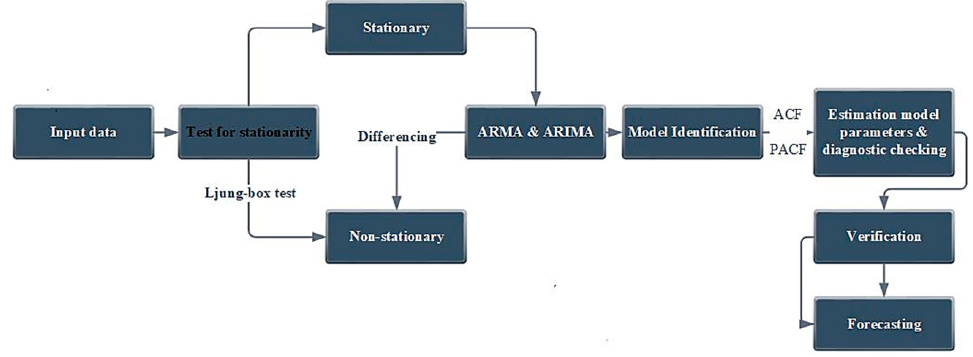
Figure 5. Flowchart of the proposed Autoregressive Integrated Moving Average modeling of daily.